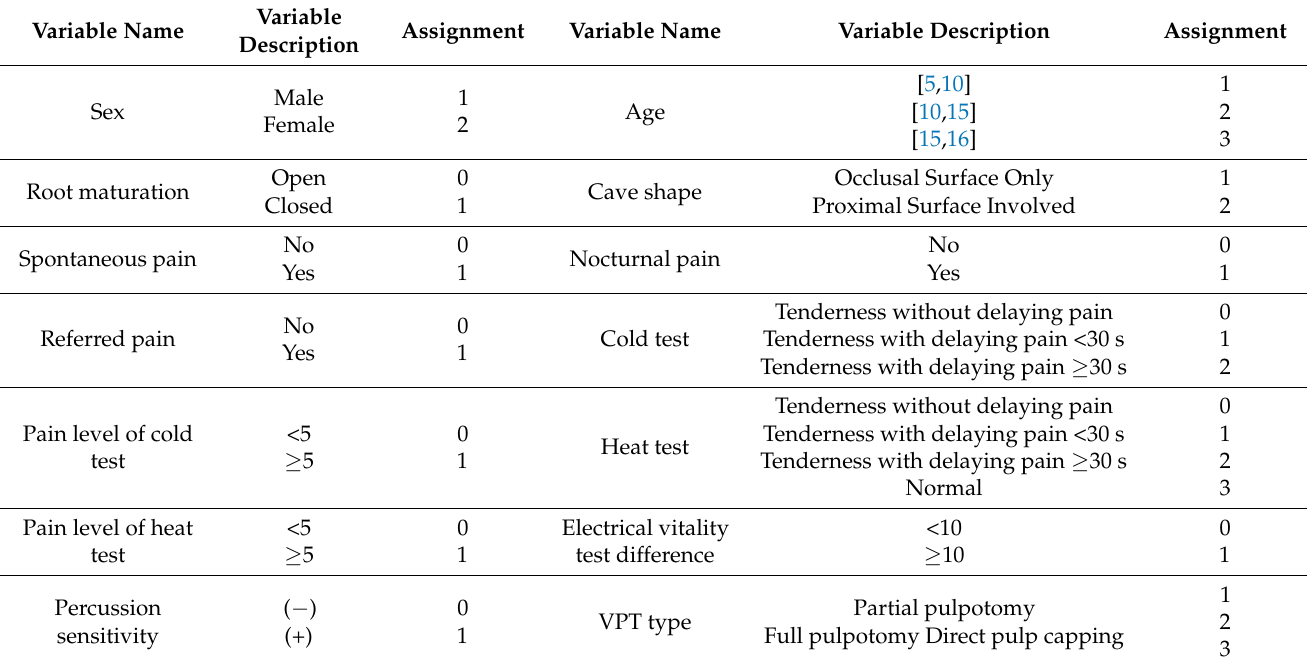
Table 1. Variable assignment of binary logistic regression model in irreversible pulpitis.